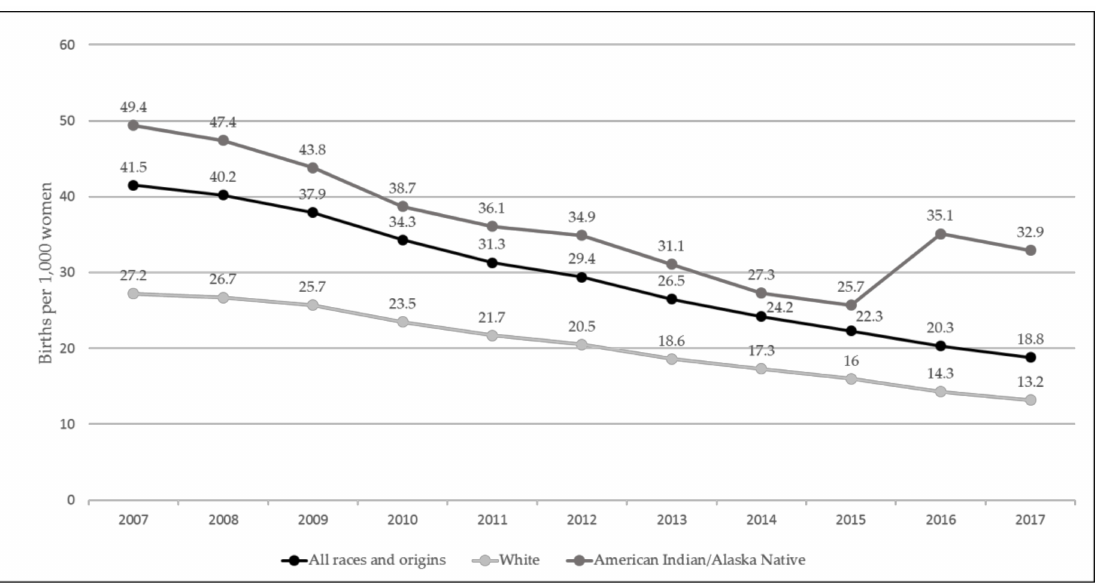
Figure 1. Teen (15–19 year olds) birth rate by race of mother (2007–2017)